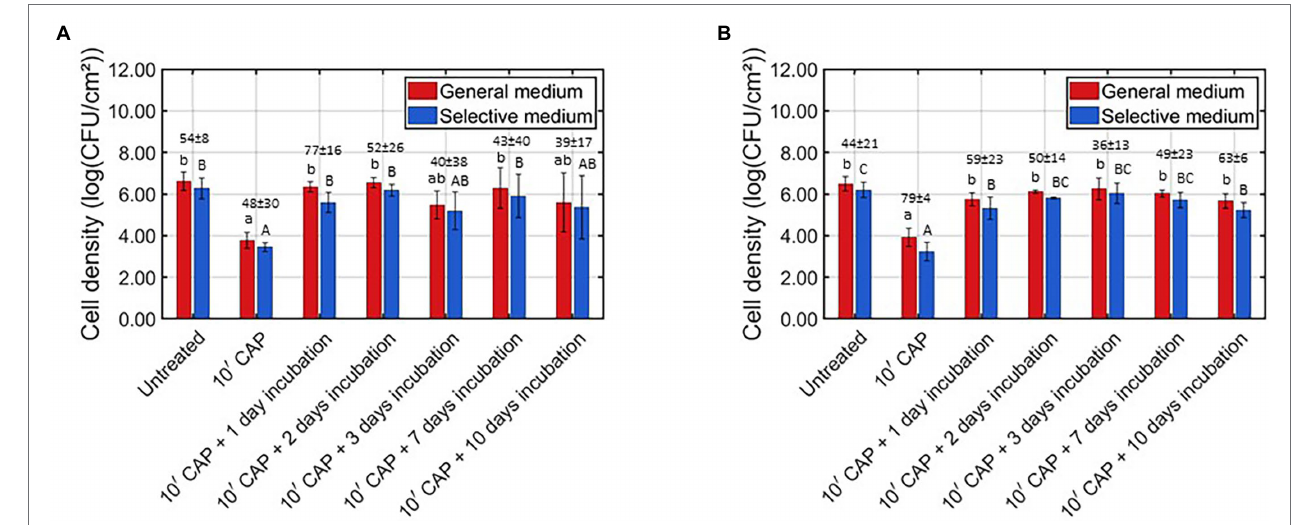
FIGURE 2 | Viable cell density [log (CFU/cm 2 )] of the untreated, CAP treated, and CAP treated + incubated model biofilms determined on non-selective and selective medium ( n = 3). Moreover, the corresponding sub-lethal injury values (average ± stdev) have been presented at the top of the bars. (A) Listeria